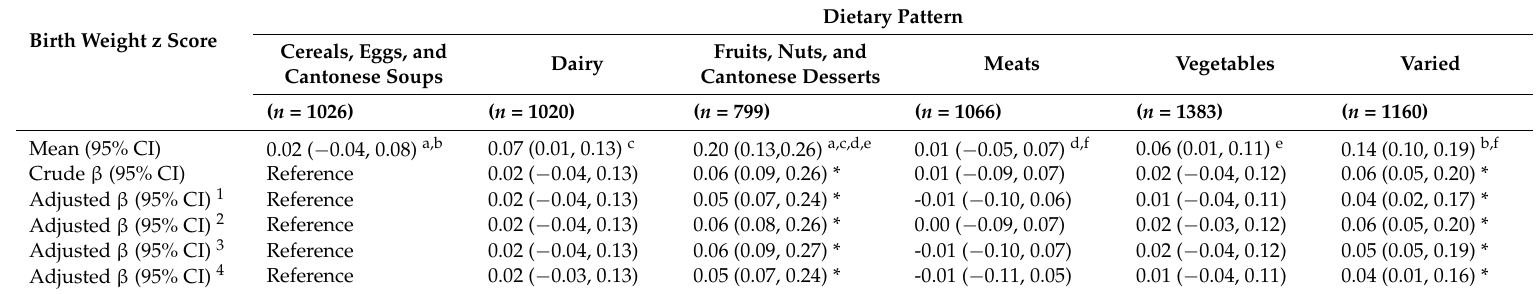
Table 3. Association between dietary patterns and neonatal birth weight Z score.